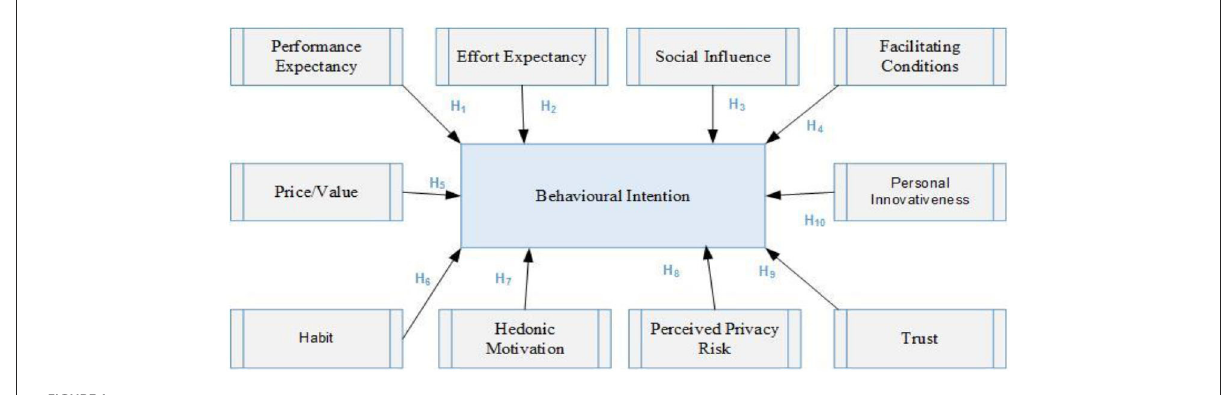
FIGURE1 The research model.